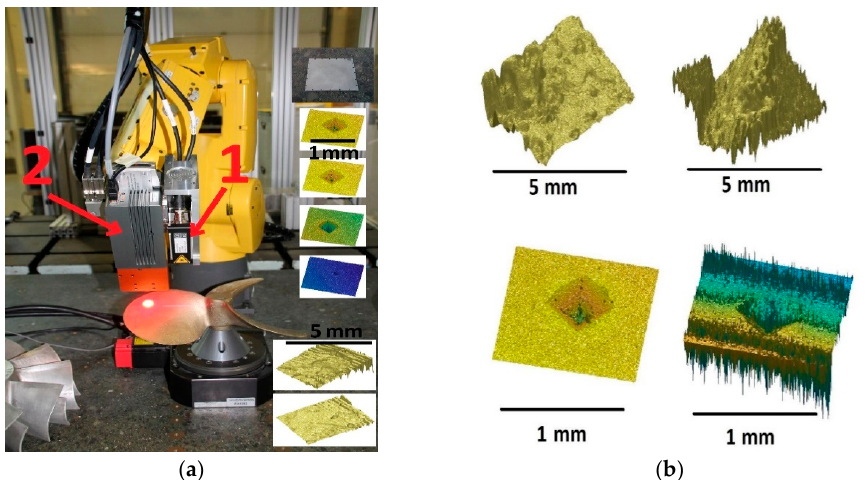
Figure 17. Robotic deployment demonstrator set-up ( a ) and measurement samples taken using the H6 (a-insets, b ) from various objects: a metal plate with various-size diamond-shape indents and a boat propeller. On ( a ), 1 marks the laser line scanner and 2 marks the H6 interferometer. The right figure shows examples of good quality scans (left column) and bad quality data due to improper instrument alignment (right column).